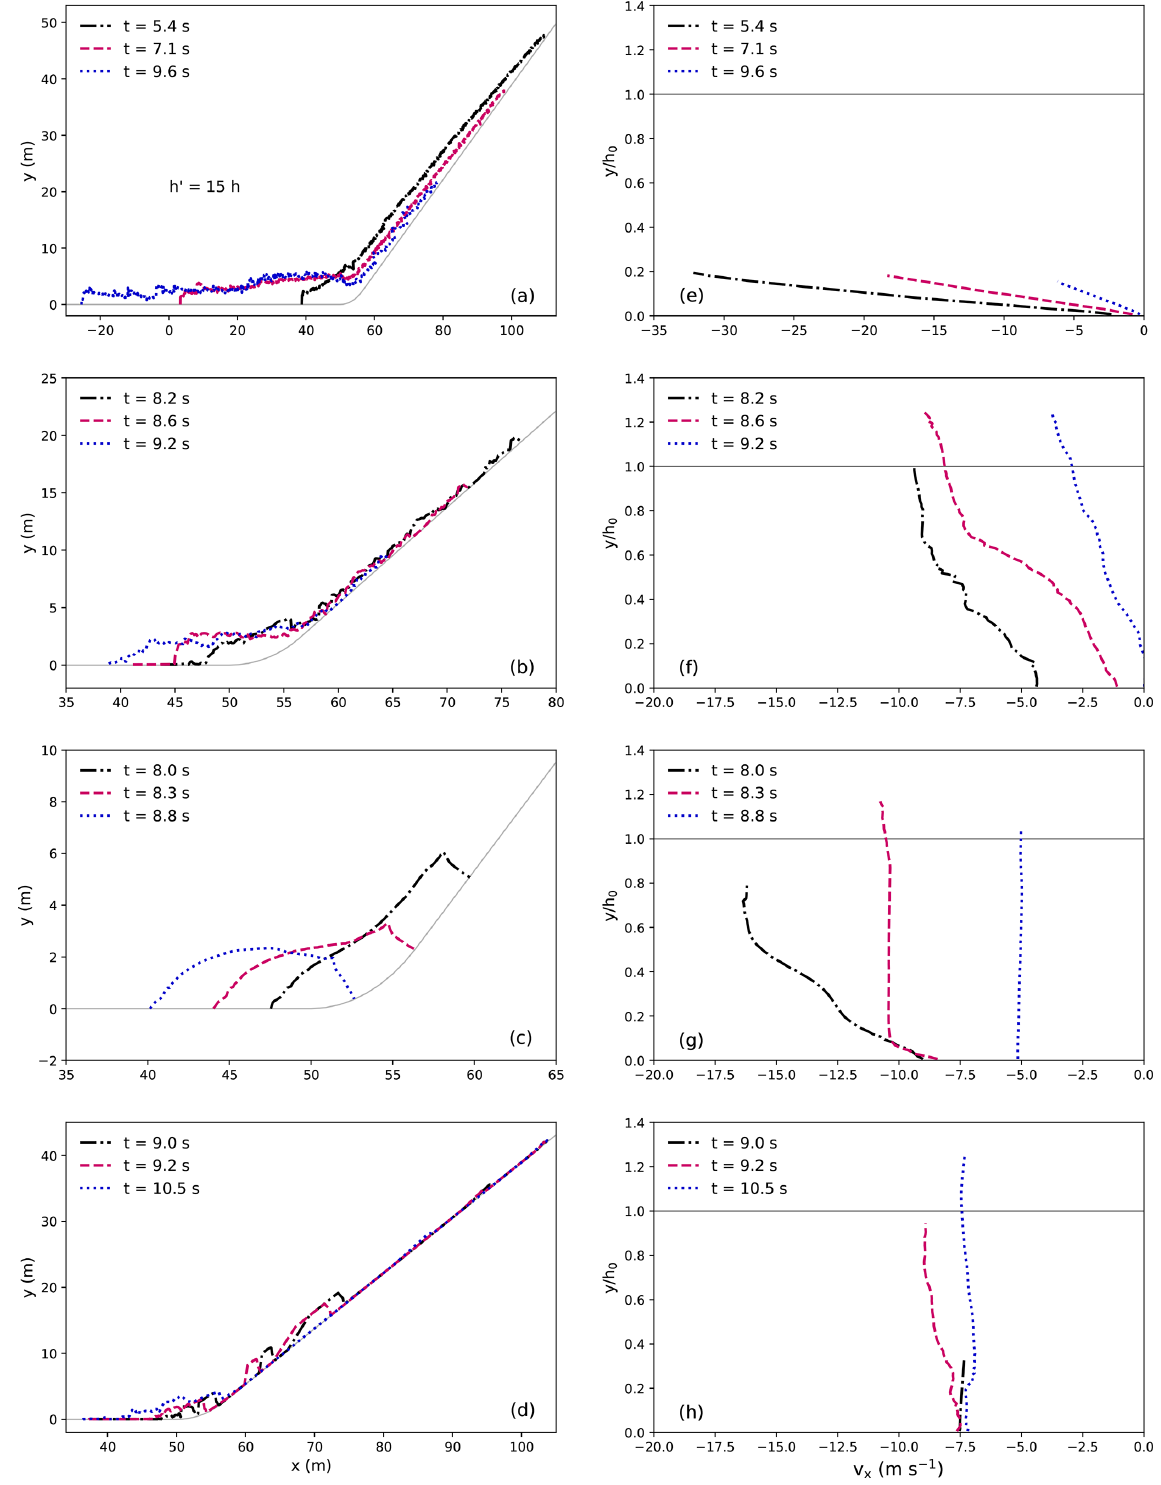
Figure 4. Evolution of free-surface shape (a–d) and velocity profile at x = 50m (e–h) for the flows in the different regimes (Table 1, Group II). (a, e) Cold dense; (b, f) warm shear; (c, g) warm plug; (d, h) sliding slab. The free surface of the cold dense flow in (a) is scaled up 15 times along the bed-normal direction for better